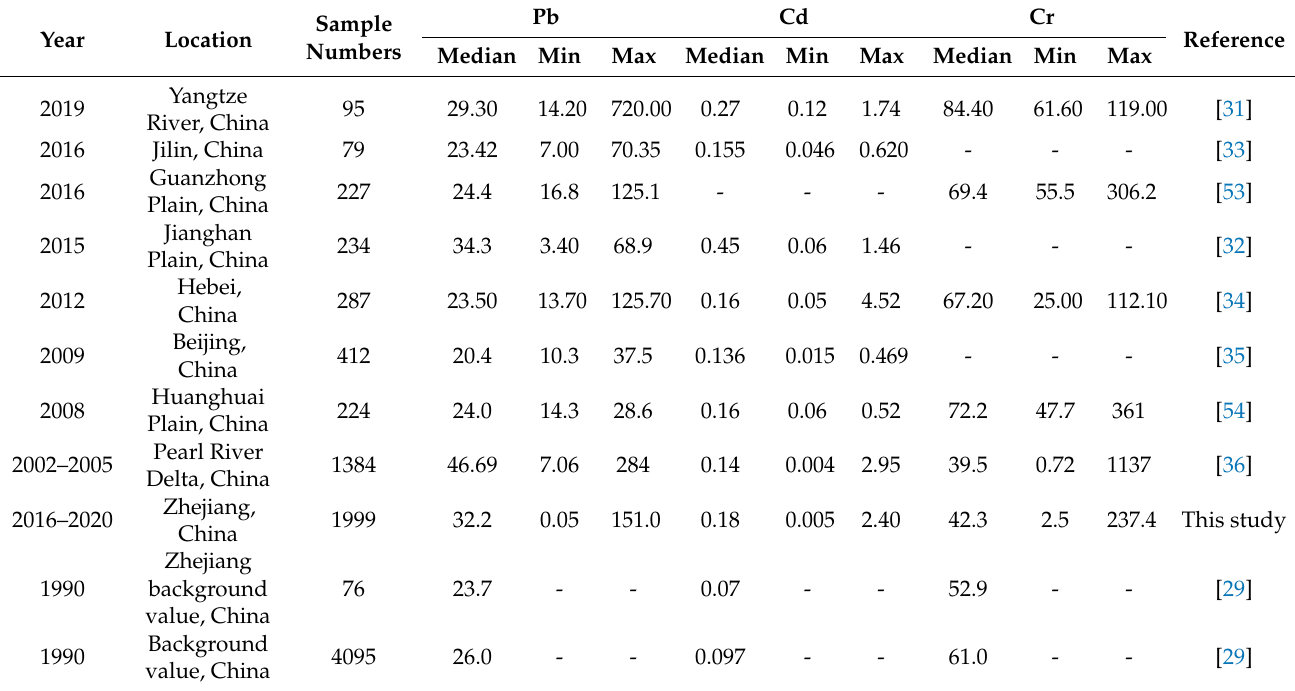
Table 1. Average concentration (mg · kg − 1 ) of heavy metals in agricultural soils in Zhejiang Province and other